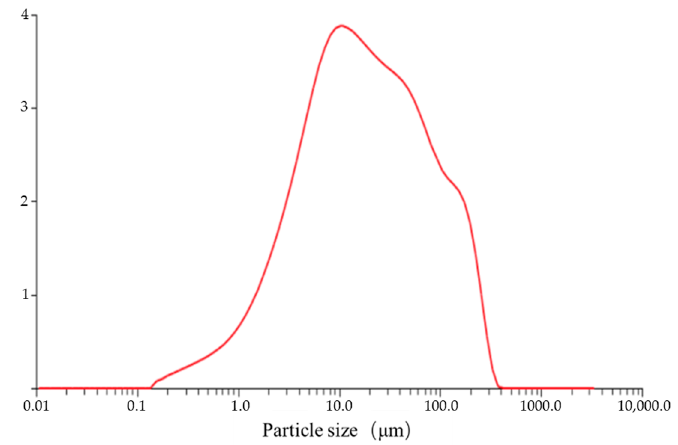
Figure 8. Particle-size distribution of ultra-fine Figure 8. Particle − size distribution of ultra − fine tailing. Table 4. Chemical compositions of raw materials (mass fraction/%).